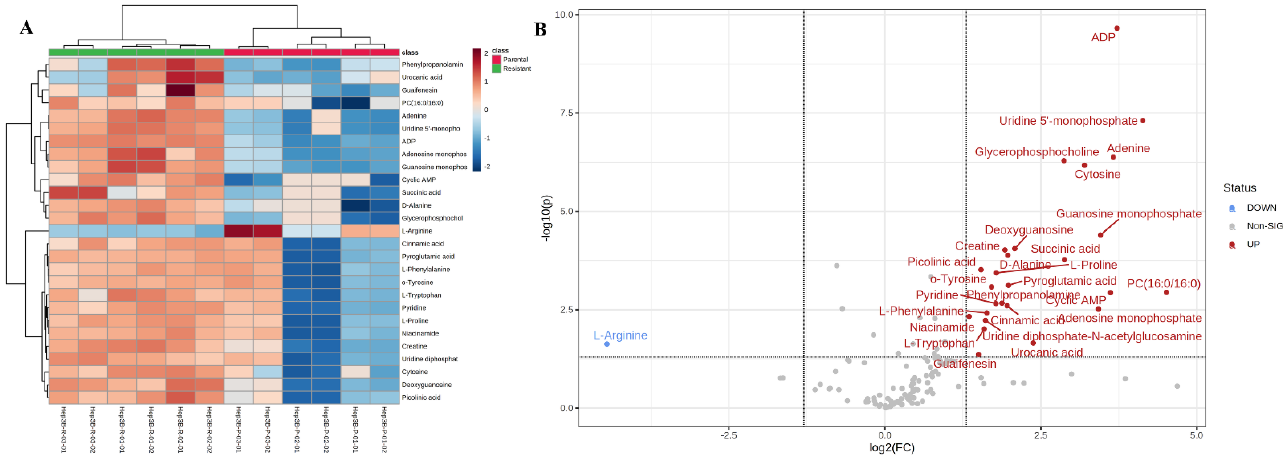
Figure 3. ( A ) Hierarchical cluster analysis and heatmap analysis of differentially abundant metabolites in resistant and parental phenotypes of Hep3B cells. Heatmap showing the abundance levels and clustering of the significantly differentially deregulated metabolites (two-sample t -test with p value < 0.05; log2FC < 2; resistant/parental Hep3B cells). Metabolite ’ s intensities up-regulated are colored in red while down-regulated are colored in blue. Row headings represent metabolites names and column headings represent samples. Euclidean distance measure and Ward linkage analysis were used to carry out hierarchical clustering using the metabolomics data. Heatmap analysis showed that metabolites clustered into two separate groups, a group representing the resistant Hep3B cells and the other group representing the parental Hep3B cells. ( B ) Volcano plots showing the metabolites that altered significantly in resistant Hep3B cells vs. parental Hep3B cells. Scatter plot showing the metabolites log2 fold-change (resistant/parental) plotted against the -log10( p value) highlighting the differentially metabolites (two-sample t -test with BH FDR < 0.05). Differentially significant metabolites which are increased in resistant Hep3B cells are indicated in red. Differentially significant metabolites which are decreased in resistant Hep3B cells are indicated in blue. Non-significant metabolites are indicated in